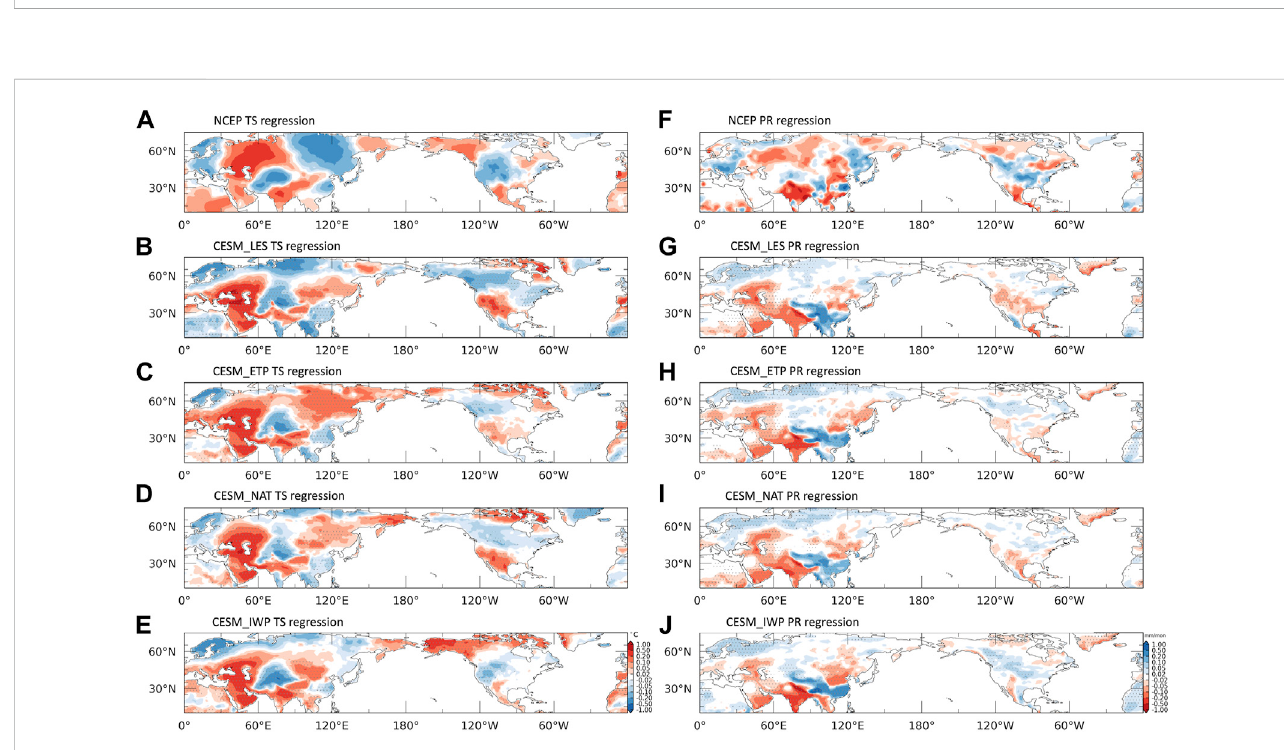
FIGURE 6 The regression coef fi cient of surface temperature (A – E) and precipitation (F – J) on summer RWS_CGT index for (A,F) the NCEP 1 reanalysis, (B,G) the CESM_LES, (C,H) the CESM_ETP, (D,I) the CESM_NAT, and (E,J) the CESM_IWP. The pacemakers use ensemble mean and the dotted areas indicate that